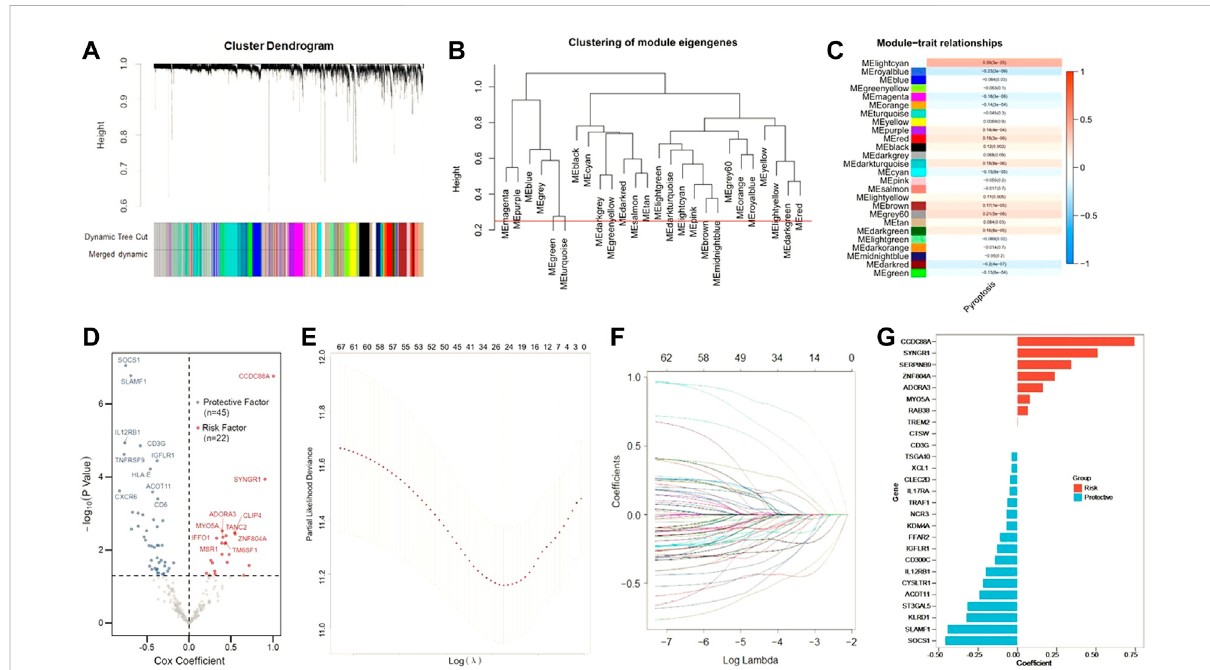
FIGURE 2 Constructionofrisksignatureinthetrainingcohort. (A) WGCNAwasperformedwithwhole-transcriptomepro fi lingdataandpyroptosisssGSEA Z-score. (B) A total of 26 non-grey modules wereidenti fi edafter merging. (C) The red module depicting the highest correlation (r= 0.18, p= 3e-06) was considered the most correlated with pyroptosis. (D) Sixty-seven promising candidates were identi fi ed among hub genes extracted from the red module. (E,F) TheLASSOCoxregressionmodelwasusedtoidentifythemostrobustmarkers,withanoptimal λ valueof0.0617. (G) Distribution of LASSO coef fi cients of the pyroptosis-related gene